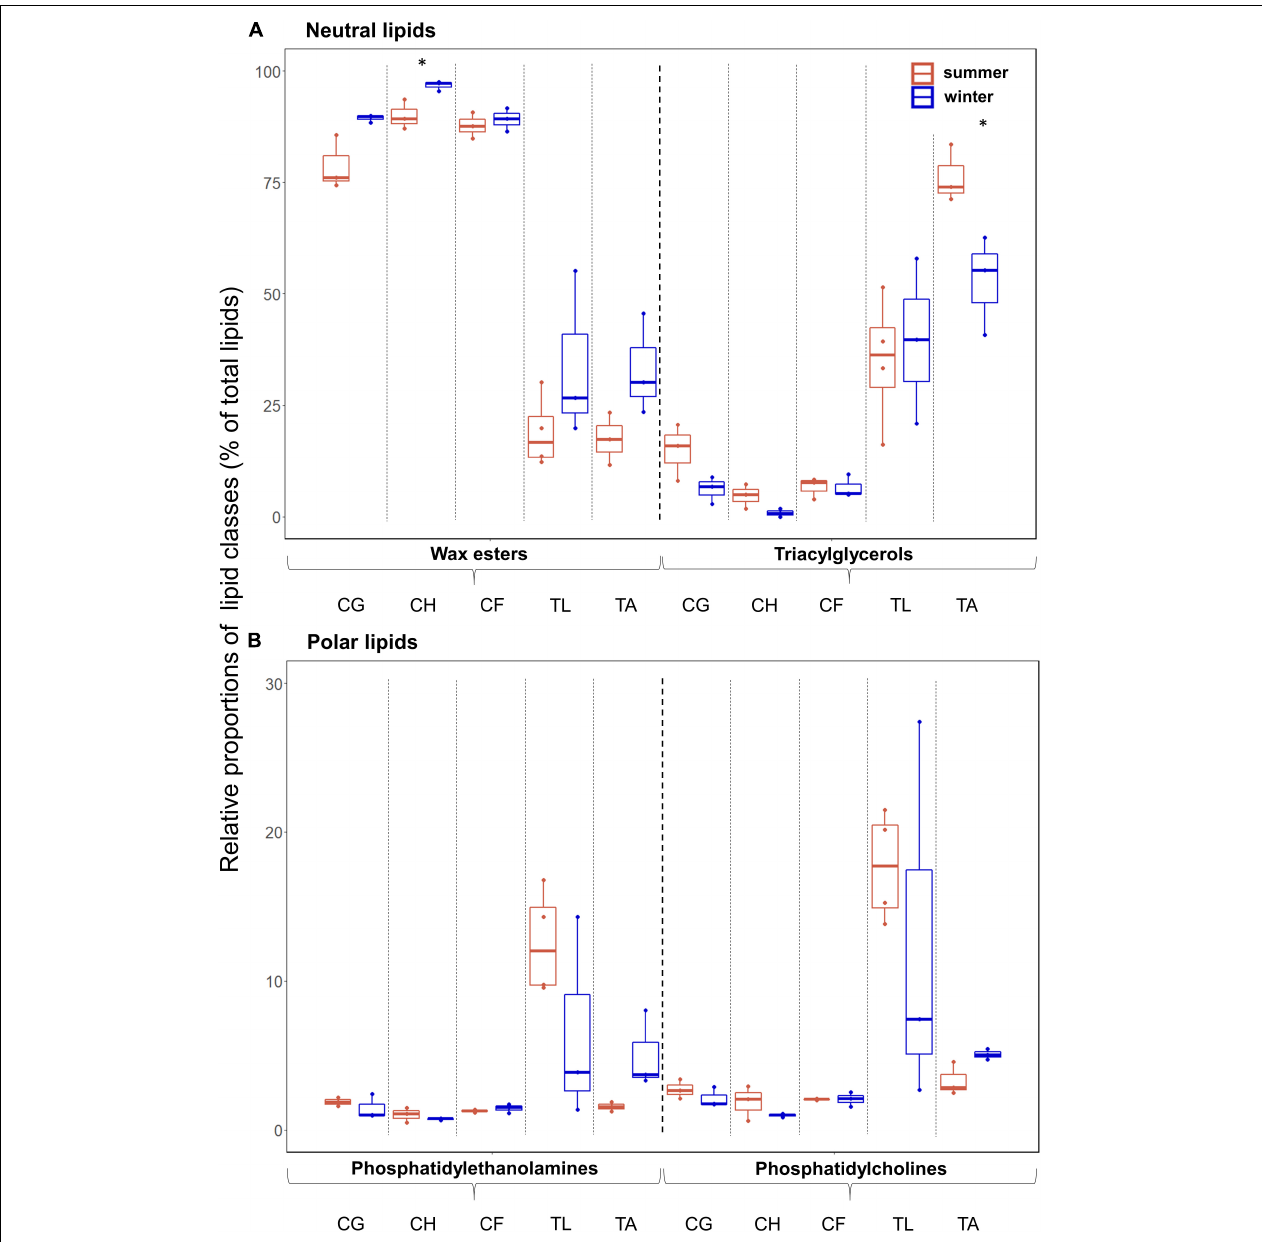
FIGURE 2 | Lipid class composition (as % of total lipids) during summer (Q3) and winter (Q4) in the zooplankton. (A) Neutral lipids and (B) polar lipids in the copepods Calanus glacialis (CG; Q3: n = 3, Q4: n = 3), C. hyperboreus (CH; Q3: n = 3, Q4: n = 3), C. finmarchicus (CF; Q3: n = 3, Q4: n = 3), and the amphipods Themisto libellula (TL; Q3: n = 4, Q4: n = 3) and T. abyssorum (TA; Q3: n = 3, Q4: n = 3). Horizontal bars in the box plots indicate median proportional values. Upper and lower edges of the boxes represent the approximate 1 st and 3 rd quartiles, respectively. Vertical error bars extend to the lowest and highest data value inside